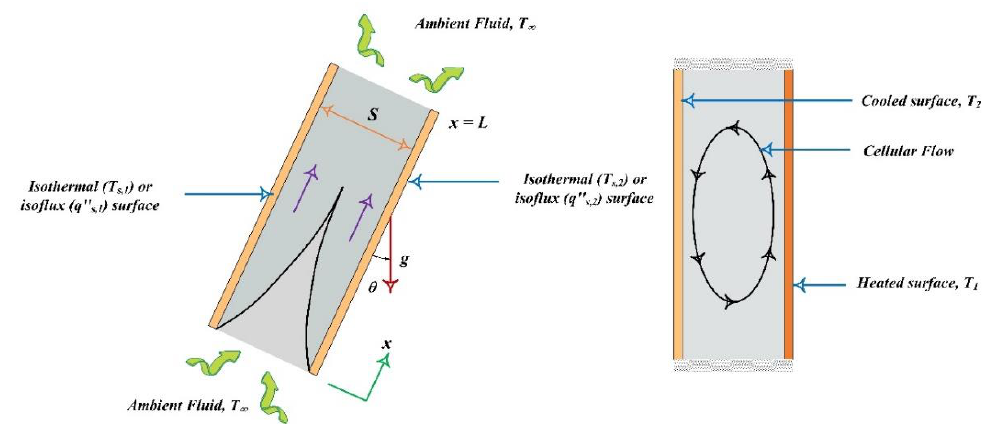
Figure 2. Internal convection flow [2].